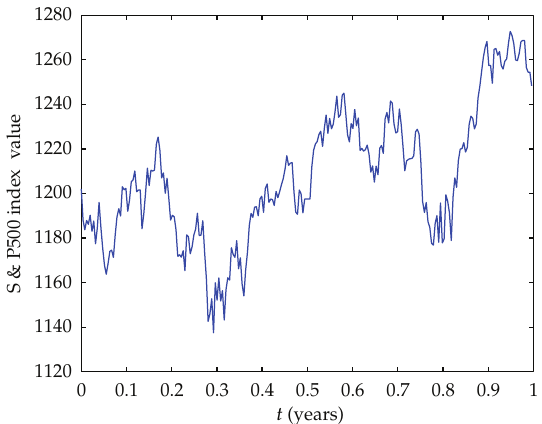
Figure 3: The S& P 500 index (cid:2) year 2005 (cid:3)